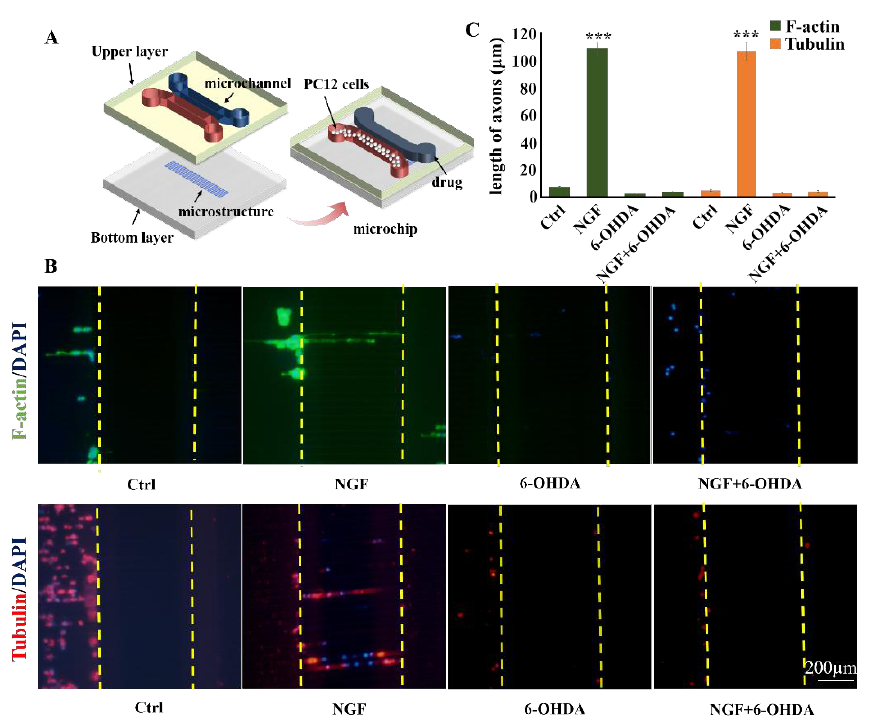
Figure 7. ( A ) Chip design. ( B ) Fluorescence images of F-actin and β -tubulin expression of PC12 cells on the combined chip after 5 days. Red, β -tubulin; blue, cell nucleus; Scale bar = 200 µm. C: Histogram of axon length of PC12 cell on the combined chip after 5 days. NGF:100 ng/mL; 6-OHDA:20 ng/mL. *** p < 0.001. The data is the mean value of each parameter for each experimental condition.